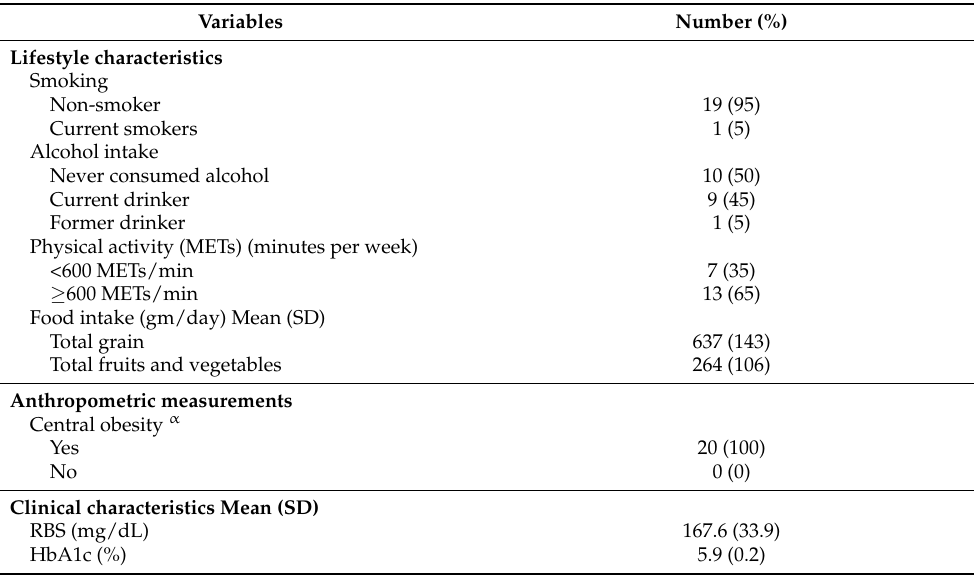
Table 2. Baseline lifestyle characteristics, anthropometric measurements, and clinical characteristics of the participants (n =